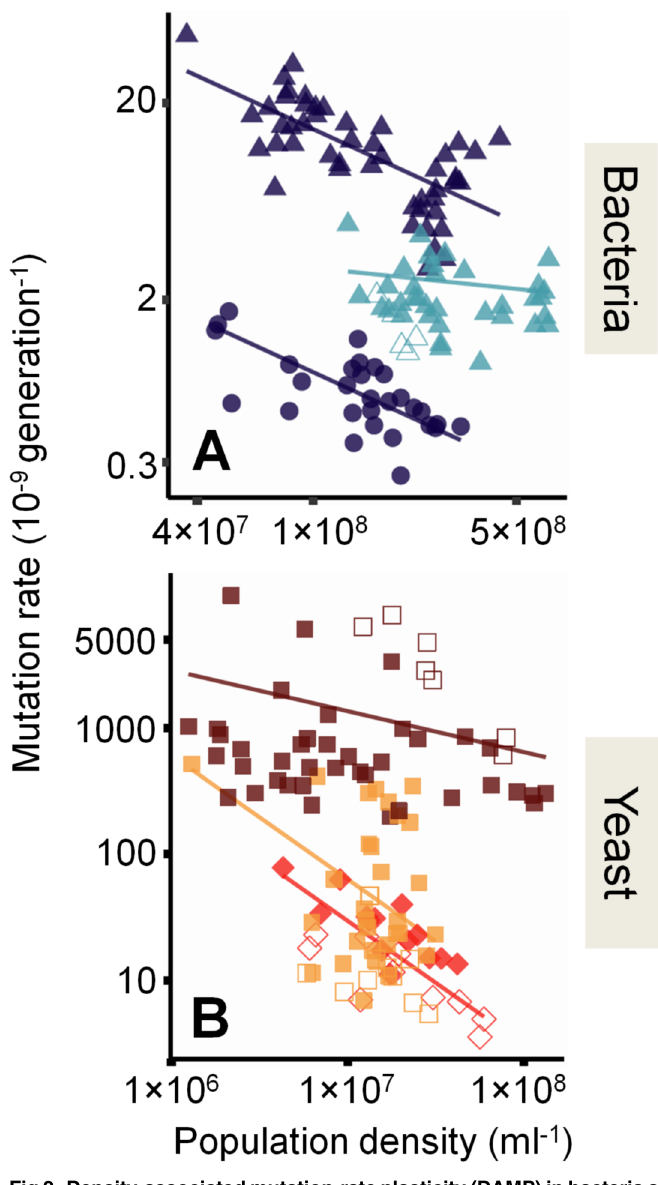
Fig 2. Density-associated mutation-rate plasticity (DAMP) in bacteria and yeast. ( A ) Mutation rates to rifampicin(triangles)and nalidixicacid (circles) resistancein E . coli MG1655 (dark blue, N = 77) and P . aeruginosa PAO1 (light blue, N = 40); lines from Model S-II in S1 Text: Wald test t 80 = 11; P = 1.7 × 10 − 18 that E . coli slope is 0; t 80 = 1.2, P = 0.22 that P . aeruginosa slope is 0. Lines are plotted separately for the 2 E . coli markers becausethere are more mutationsconferringrifampicinresistance(in the rpoB gene) than nalidixic acid resistance(in the gyrA gene), resultingin different overallrates. ( B ) Mutation rates to hygromycinB (squares) and 5-Fluoro-orotic acid (5-FOA, diamonds) resistancein S . cerevisiae BY4742(brown, N = 46), Sigma1278b (orange, N = 41), and S288C(red, N = 24); lines from Model S-III in S1 Text: t 81 = 9.6; P = 4.3 × 10 − 15 Wald test that average S . cerevisiae slope with D is 0; likelihoodratio test that slopes are equal amongstrains LR 1 = 17, P = 4.1 × 10 − 5 . Open shapes denote mutation-rate estimates that wouldtypically be excludedbecausethe estimated numberof mutational events per culture, m , is either below0.3 or above 30. Populationdensitiesestimated by ATP-based assay in ( A ) and direct cell counts in ( B ). See main text for the slope estimates of the given lines. Note the logarithmic axes. Raw data are available in S1 Data.